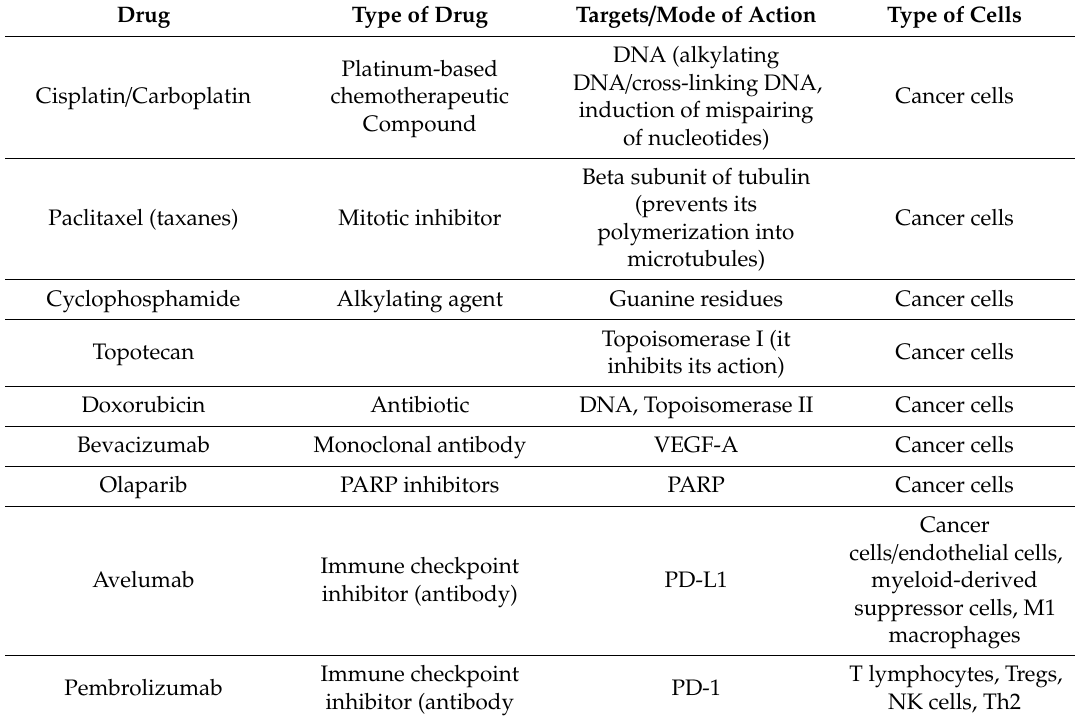
Table 1. Molecular targets of drugs applied in ovarian cancer treatment. Drug Type of Drug Targets / Mode of Action Type of Cells DNA (alkylating Platinum-based DNA / cross-linking DNA, Cancer Cisplatin / Carboplatin chemotherapeutic induction of mispairing Compound of nucleotides)